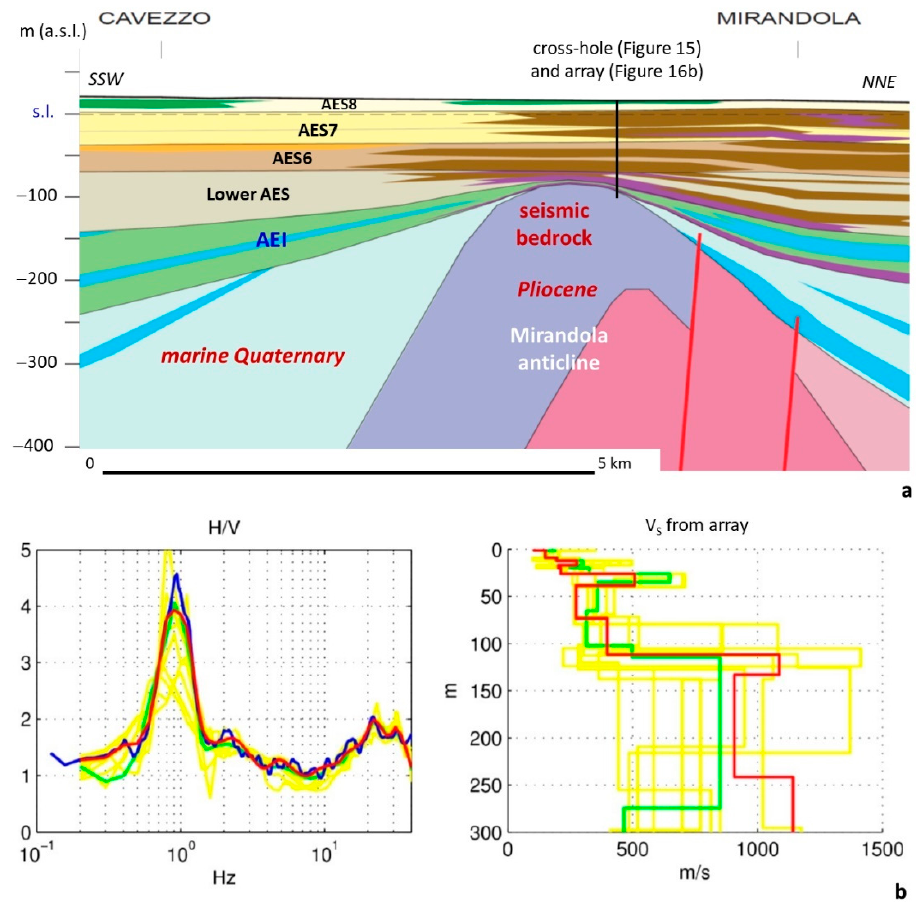
Figure 16. (a) Geological cross-section across the Mirandola anticline, ( b ) H/V spectral ratio and Vs profile from ambient vibration measurement (array) in the Mirandola urban area [19].